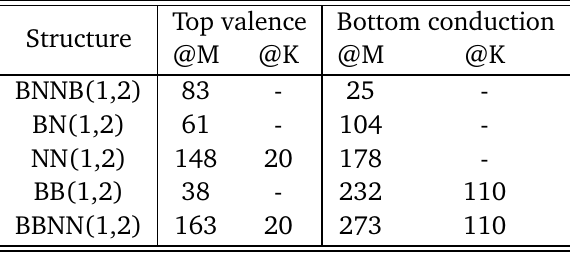
Table 2: The band splitting (meV) at M and K in the top valence and bottom conduc- tion of the (1,2) supercells. The symbol ‘-’ indicates a band crossing. These features are highlighted with red vertical lines in Figure 3.